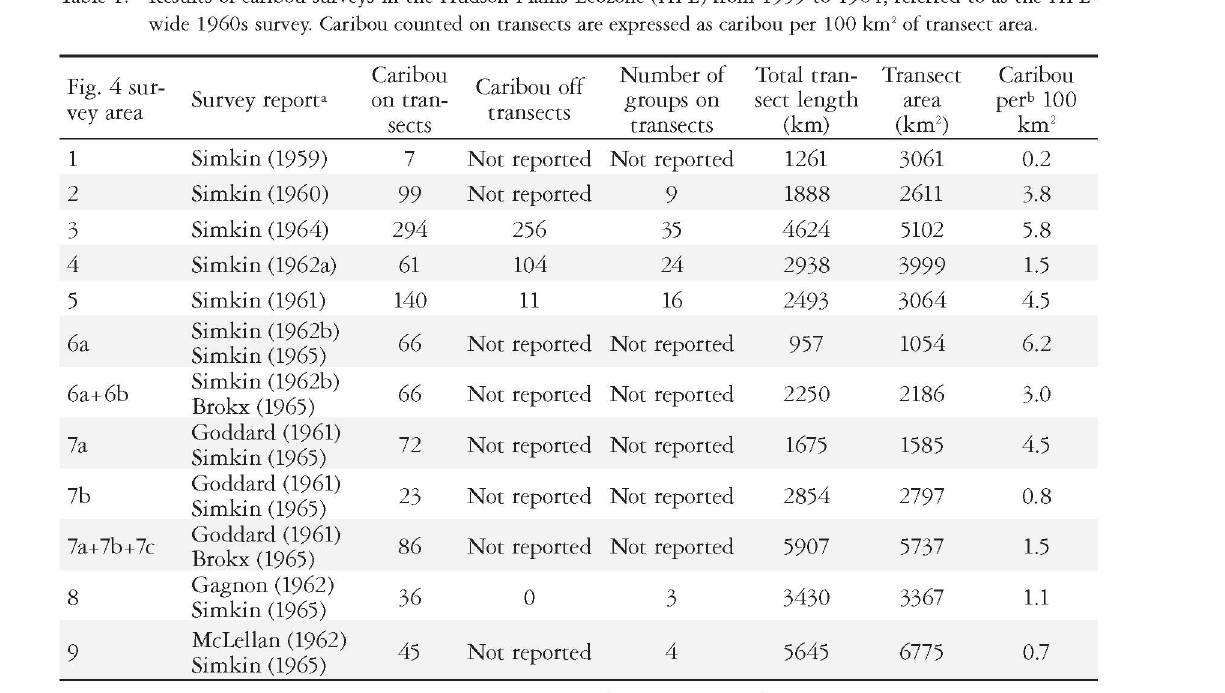
Table 1. Results of caribou surveys in the Hudson Plains Ecozone (HPE) from 1959 to 1964, referred to as the HPE-